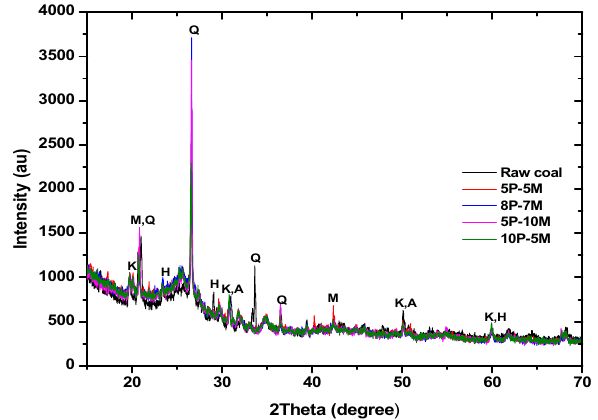
Figure 2. Diffractograms bio-coal briquette produced from 95:5 hybrid ratio.